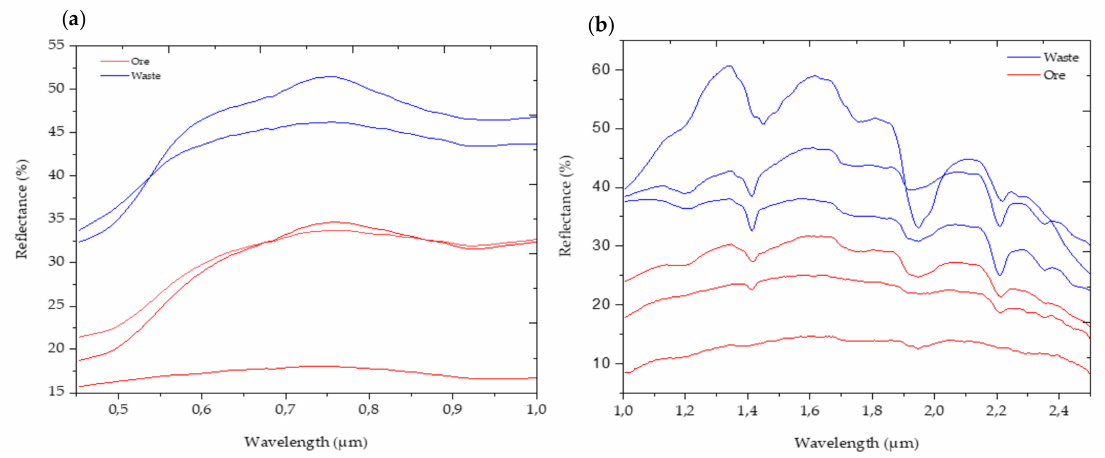
Figure 6. Representative spectra of samples that belong to ore and waste classes in the ( a ) VNIR and ( b ) SWIR wavelength